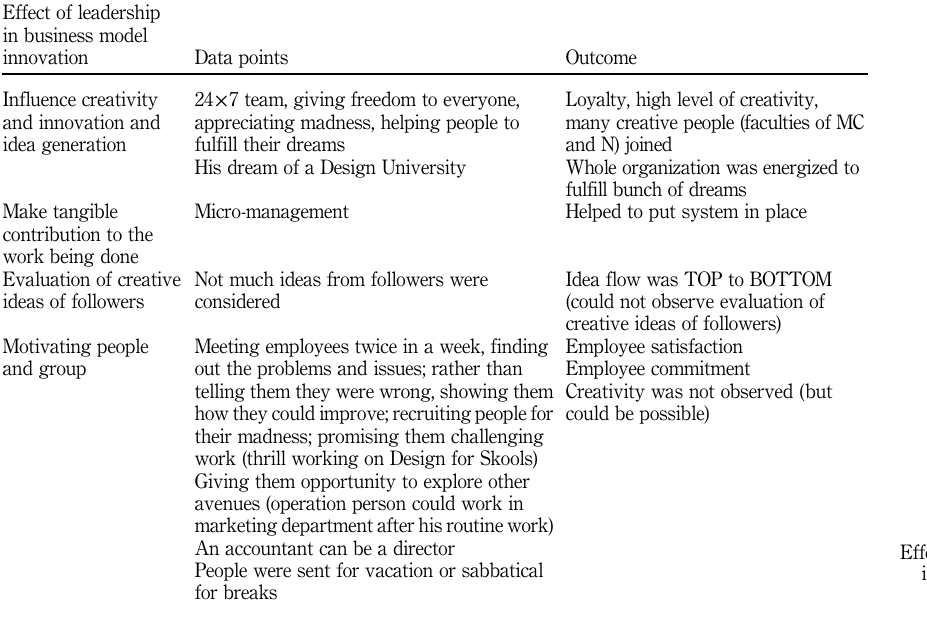
Table III. Effects of